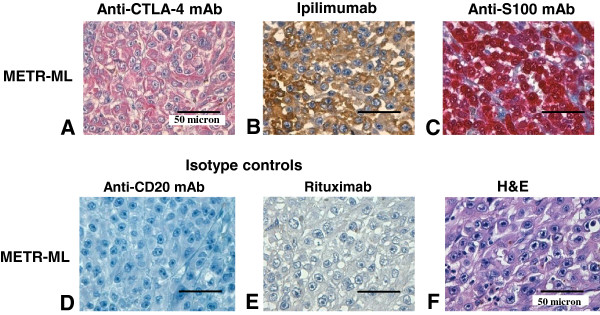
CTLA-4 is expressed in cutaneous melanoma tissues and it is recognized by Ipilimumab. Immunohistochemical (IHC) analysis is shown in a representative metastatic melanoma lesion (ML). IHC staining with murine anti-CTLA-4 14D3 mAb of METR-ML (A) was detected with AP-conjugated secondary antibody and Fast Red chromogen (red staining). IHC staining with Ipilimumab of METR-ML (B) was detected with HRP-conjugated secondary antibody and DAB chromogen (brown staining). IHC staining with anti-S100 mAb was used as positive control as shown in the representative METR-ML (C) sample. IHC stainings with a murine anti-CD20 mAb and human Rituximab anti-CD20 mAb were used as isotype negative controls for 14D3 and Ipilimumab, respectively, as shown for METR-ML (D,E). Images were taken using magnification 630×. Scale bar, 50 micron.